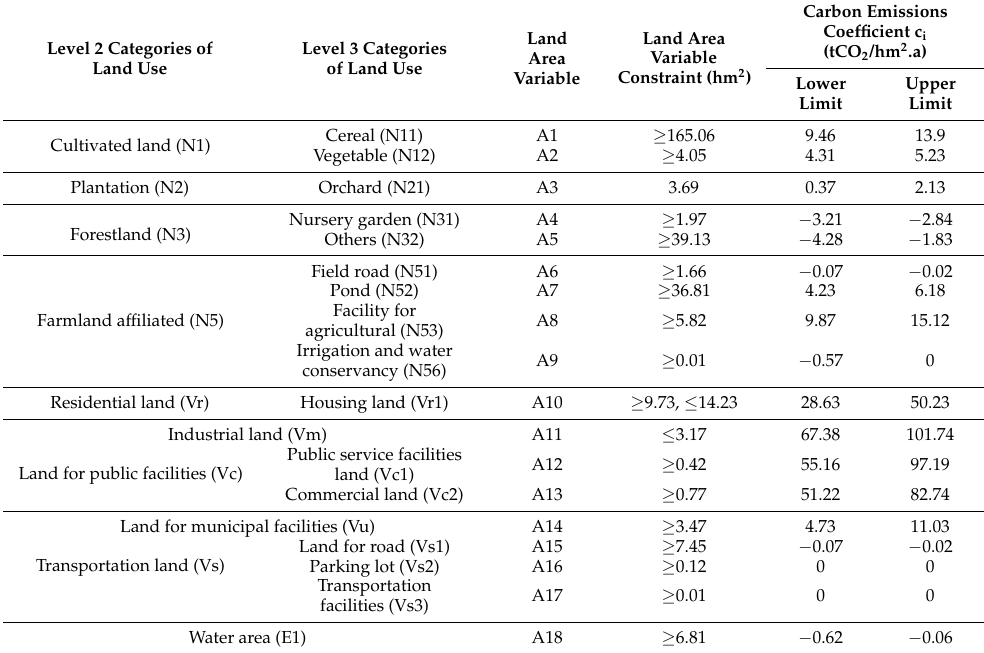
Table 5. Land-use constraints and carbon emissions coefficient